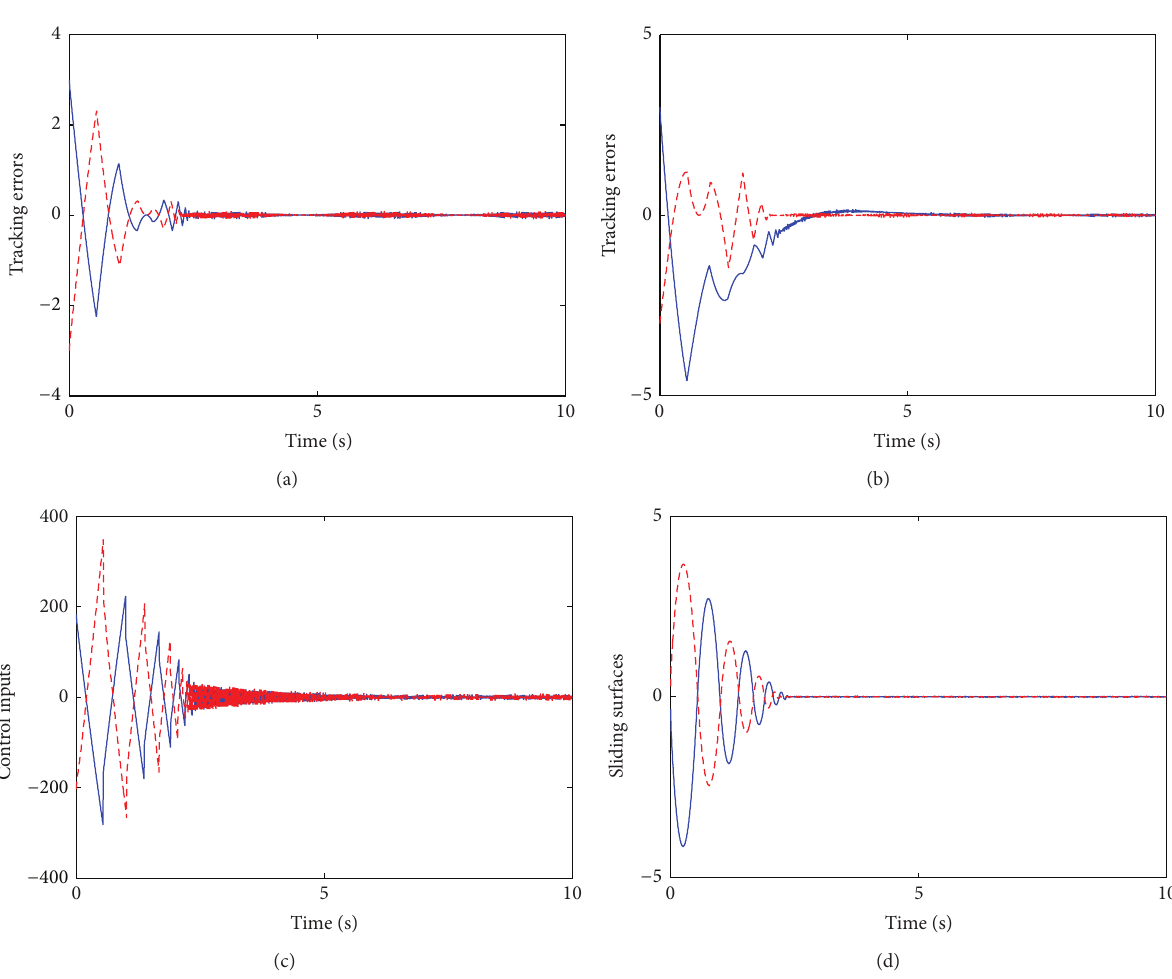
Figure 3: Simulation results for Example 1: (a) tracking errors: 𝑒 1 (solid line) and ̇𝑒 1 (dashed line). (b) Tracking errors: 𝑒 2 (solid line) and ̇𝑒 2 (dashed line). (c) Control inputs: 𝑢 1 (solid line) and 𝑢 2 (dashed line). (d) Sliding surface: 𝑠 1 (solid line) and 𝑠 2 (dashed line).